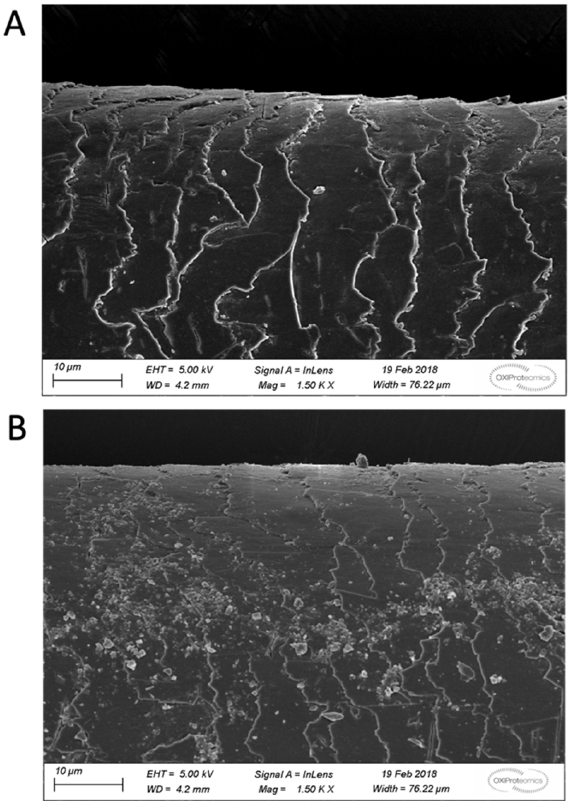
Figure 2. The adhesion of particulate matters on hair surface is detected and presented by image collection via scanning electron microscopy (SEM). ( A ) Not treated hair fiber; ( B ) hair fiber exposed to airborne pollutants (PM).